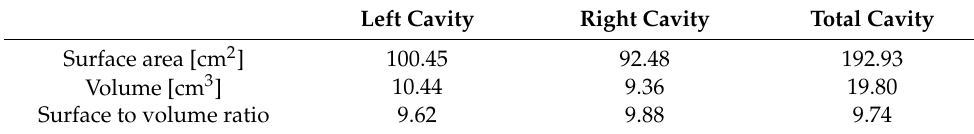
Table 1. Model surface and volume information of the 77-year-old male nasal subject. Left